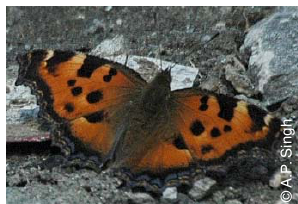
Image 127. Mountain Green-veined White, Pieris montana (under)